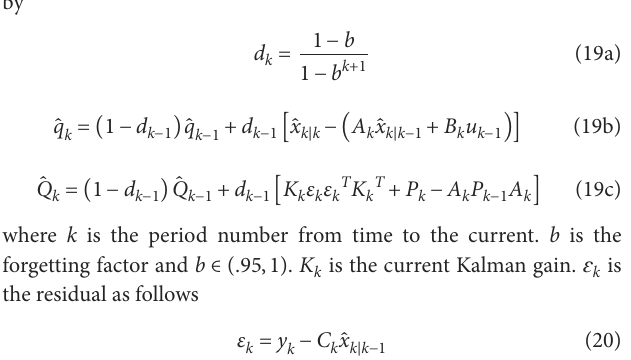
remaining parameters without projection are set to 0. As shown in Figure 7 , the polyhedra are divided into 240 blocks, and the actual trajectory converges from the initial point (0, 0) to the point (25, 0), via blocks 156 and 162 to block 1. This example shows that it is feasible to solve the QP problem by dividing the polyhedra